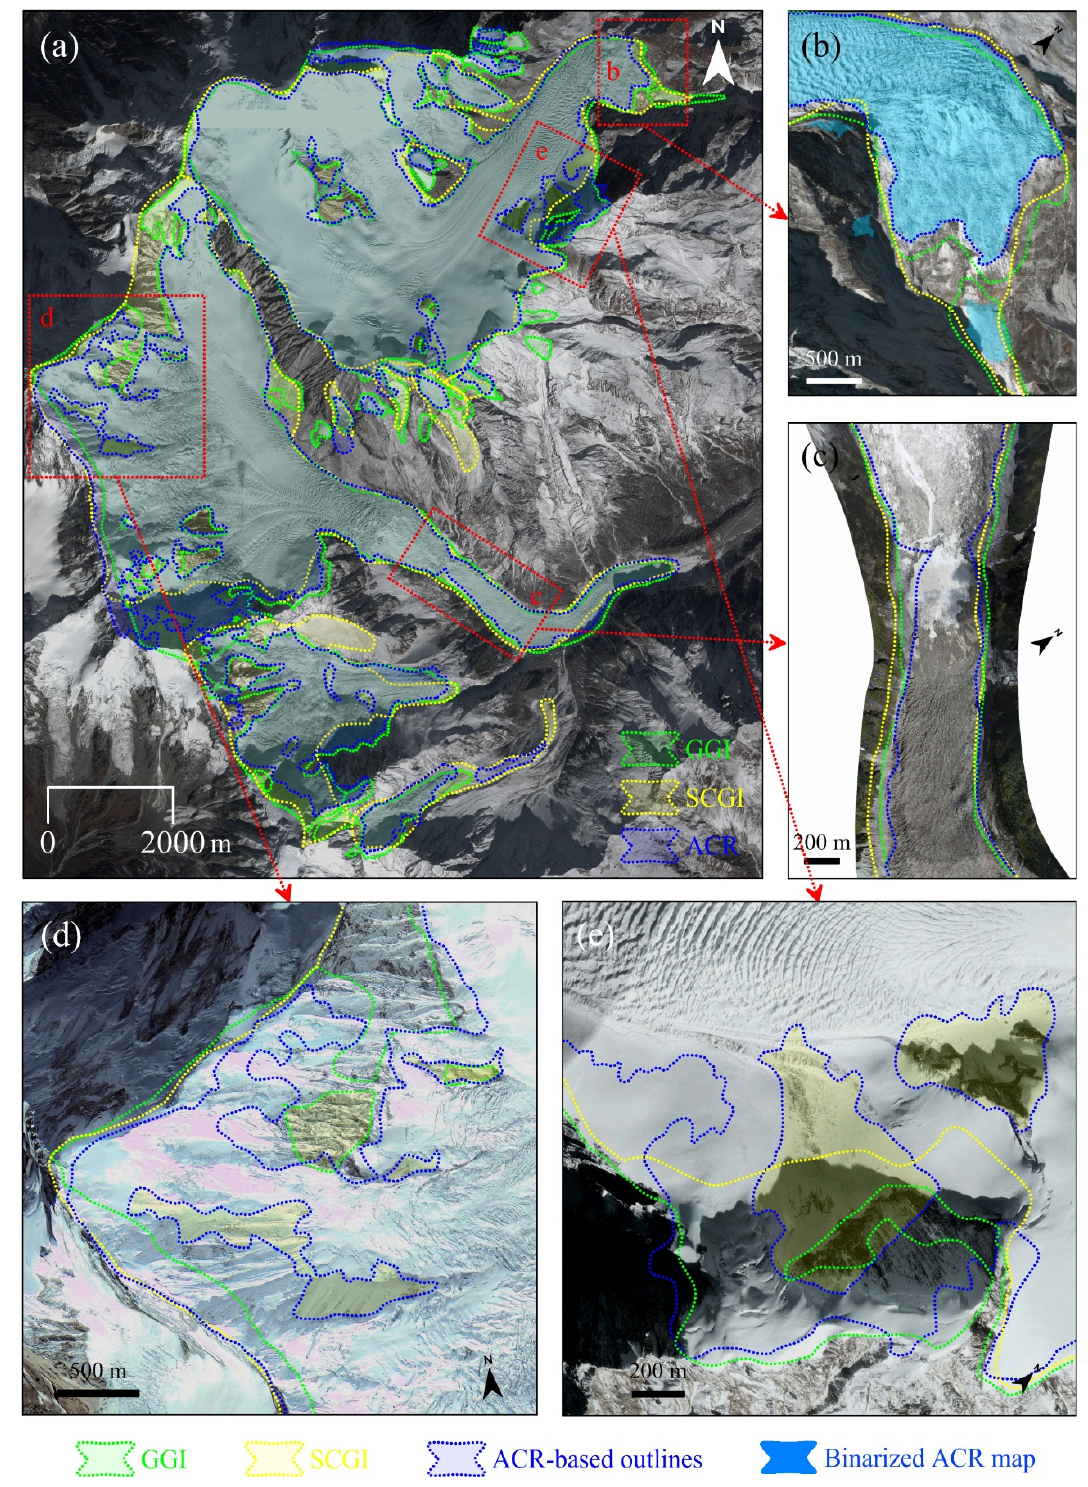
Figure 10. Visual comparison of glacier boundaries derived by the proposed method with current glacier inventories. ( a ) Comparison of the boundaries from SCGI, GGI, and this study superimposed on Sentinel-2 images acquired on 6 November 2017; ( b , d , e ) are enlarged glacier outlines corresponding to the red dashed box in ( a ) superimposed on Google Earth. ( c ) Regional glacier outlines superimposed on the orthophoto image derived from a UAV on 5 June 2019.